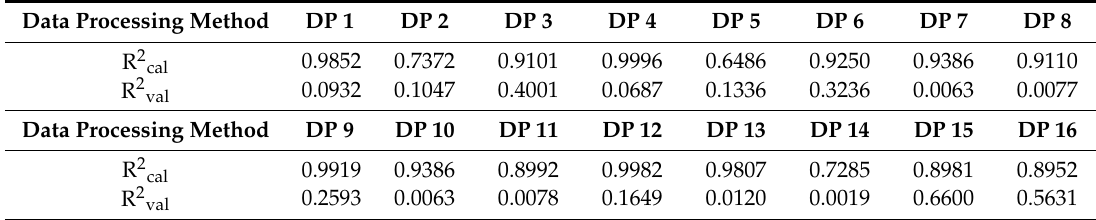
Table 2. PLSR detection results of TSS based on full spectral data with data processing methods.